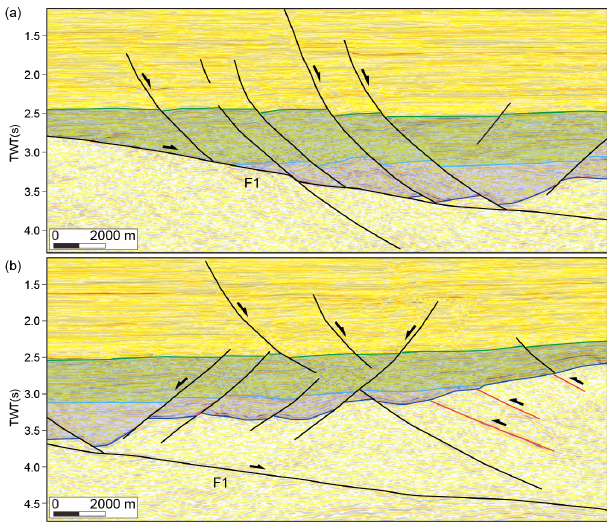
Figure 8. Cross sections showing the assemblage style of minor faults. (a) Domino faults developing on the slipping plane of the major fault F1. (b) Conjugate fault developing on the gentle slope of the Enping sag. See Fig. 1 for the location of these cross